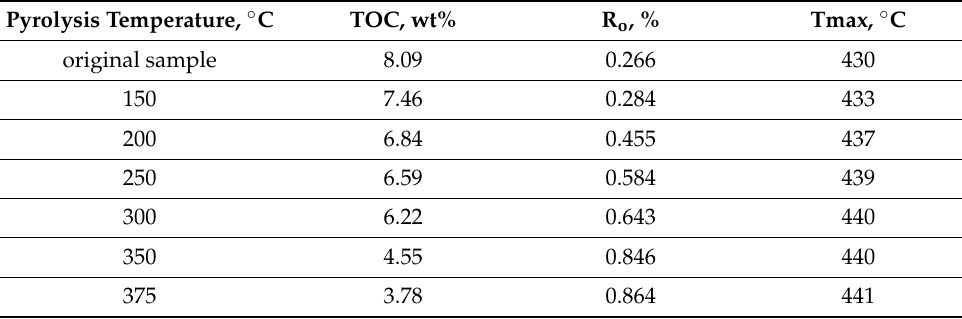
Table 2. TOC, R o and T max values of Nongan samples at different pyrolysis